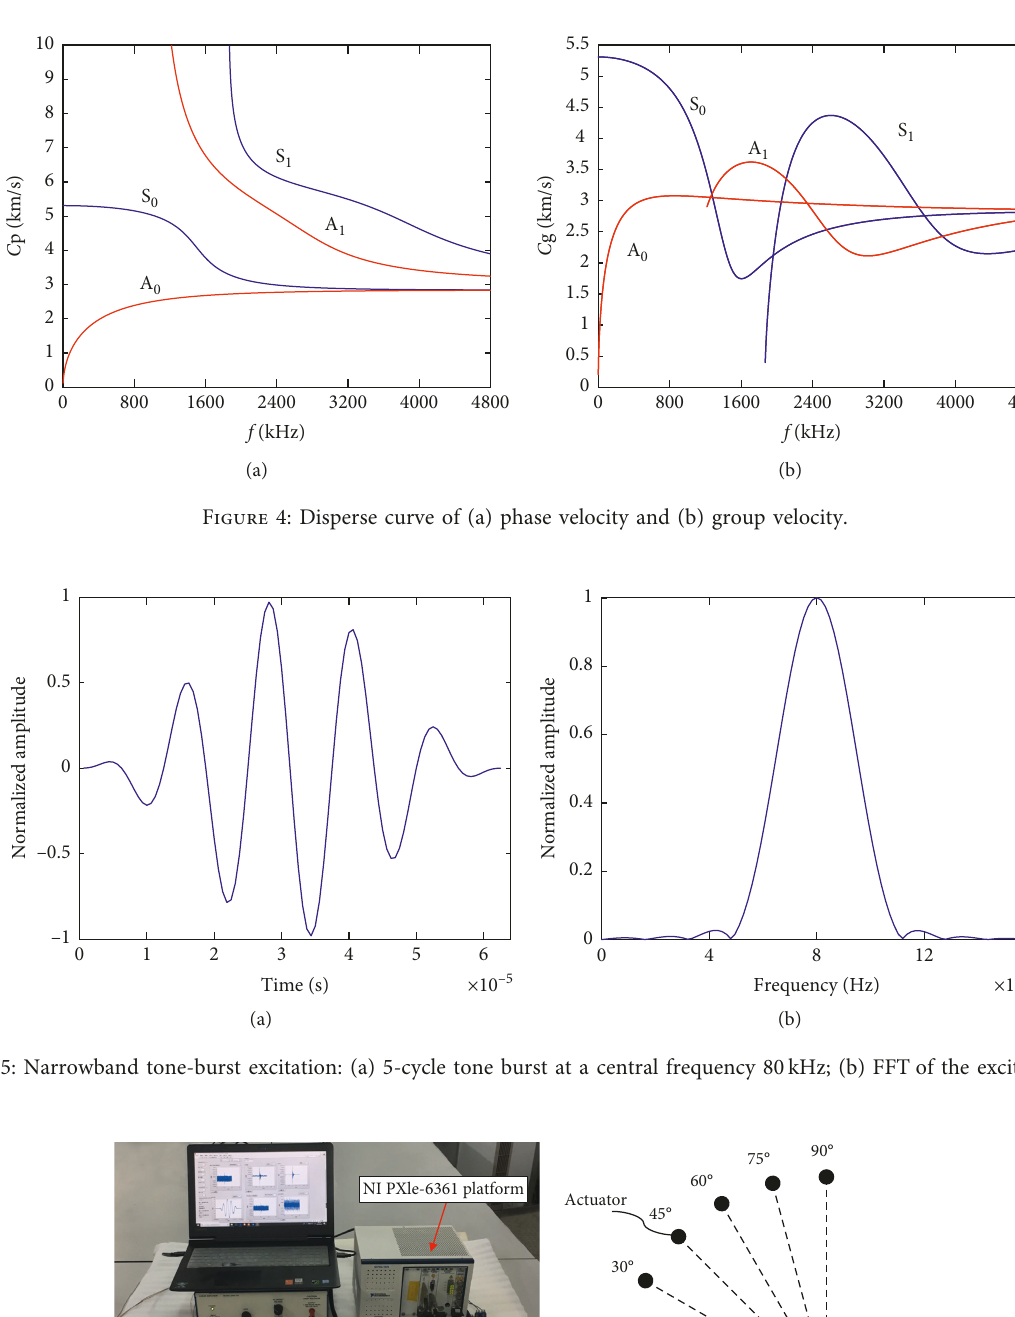
NI PXle-6361 platform